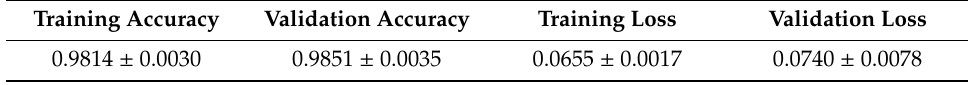
Figure 7. The visual correspondence between the true-color Sentinel-2 256 × 256 image patch, the associated reference mask of aquatic vegetation ( white ) generated using the Otsu + Canny method, and the MultiResUnet aquatic vegetation prediction mask over portions of Hartbeespoort dam, South Africa. Each row represents an example from the test data. The first two rows cover the same portion of Hartbeespoort dam viewed on different days. Table 2. The training and validation mean ( ± SD) accuracy and binary cross entropy loss / error for the semantic segmentation (MultiResUnet) of aquatic vegetation (examples are shown in Figure 3). Note, accuracy values closer to one, and low loss values closer to zero are better and are based on Otsu + Canny reference masks. The last epochs’ scores are averaged over three iterations (lasting 94, 76, and 83 epochs